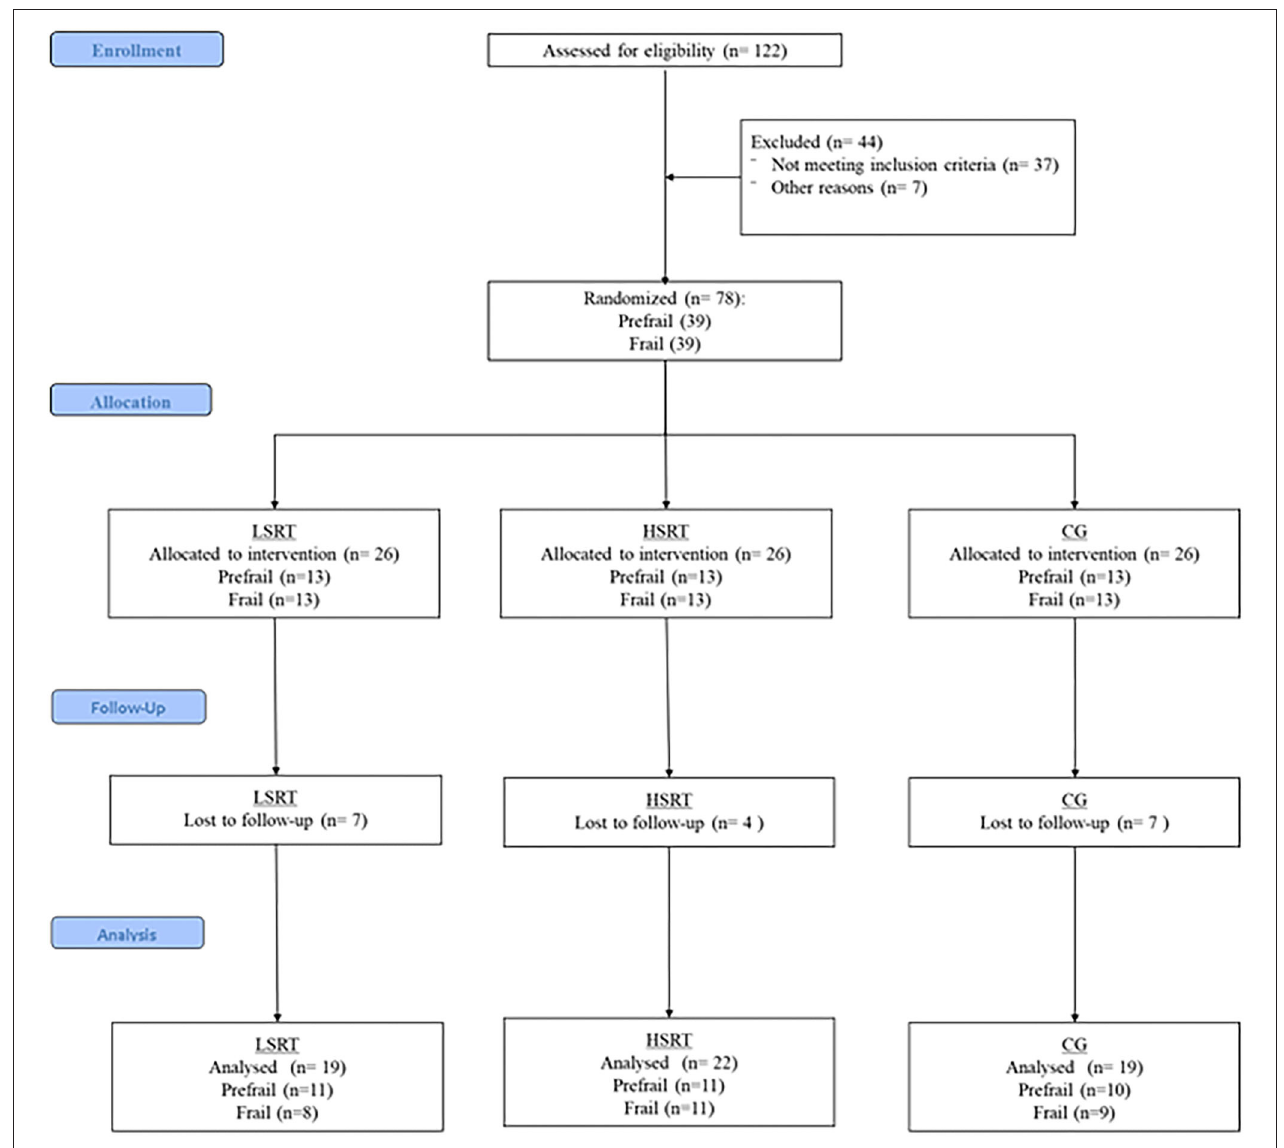
FIGURE 1 | Flowchart of the present study. LSRT, Low-speed resistance training; HSRT, High-speed resistance training; CG, Control group.